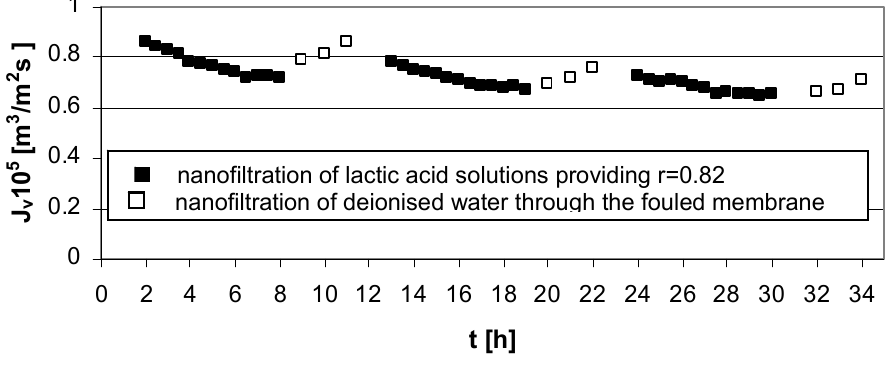
Figure 3. Permeate flux decline vs. time for operating parameters providing high lactic acid rejection, r = 0.82 (Table 1); series 1, 2, 3—nanofiltration of lactic acid solutions; series 1w, 2w, 3w—nanofiltration of water (“w” is the DI symbol for each series); concentration of lactic acid c = 0.02 mol/dm 3 , pH = 8.0, transmembrane pressure LA Δ p = 5.5 MPa, cross flow velocity u = 1.0 m/s.